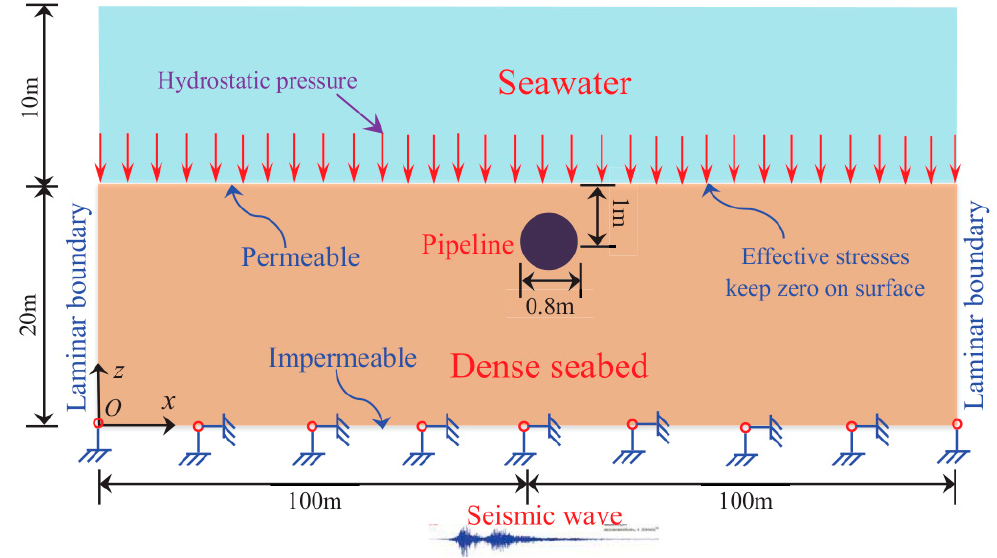
Figure 1. Sketch map of the pipeline-seabed system adopted in computation. A submarine pipeline is buried in the dense seabed foundation. Only the hydrostatic water pressure is applied on the surface of seabed, and the laminar boundary condition is applied on the two lateral sides.